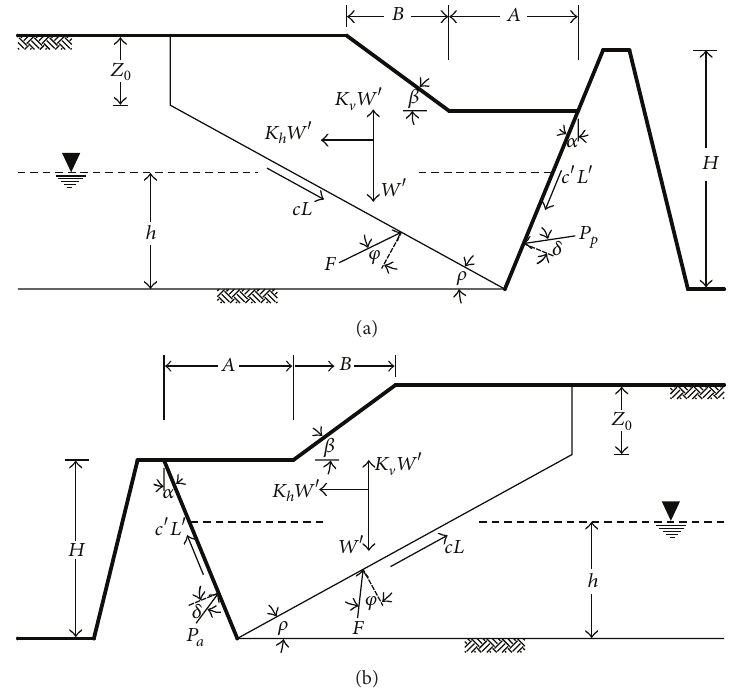
Figure 3: Proposed model for passive (a) and active (b)